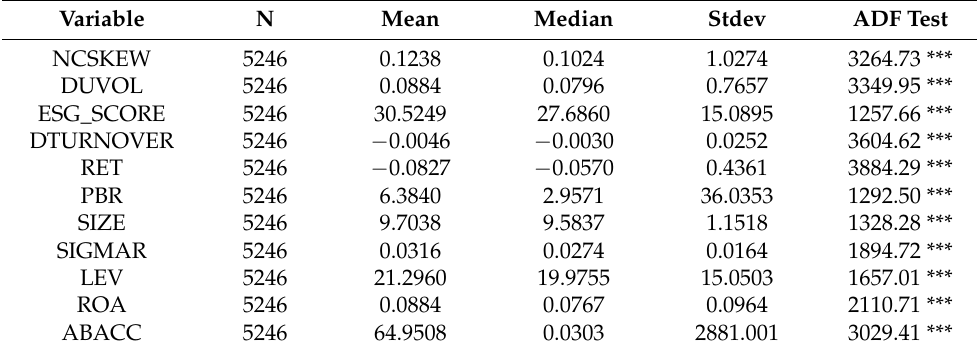
Table 3. Descriptive statistics for S&P 500 members.